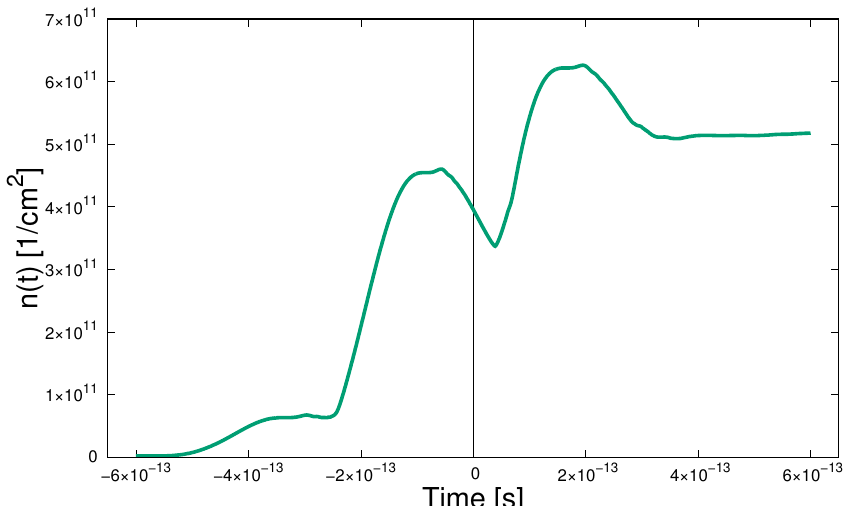
Figure 7. The carrier density evolution for the field of Figure 5 for a time interval from to 6.0 10 − 13 s. ×